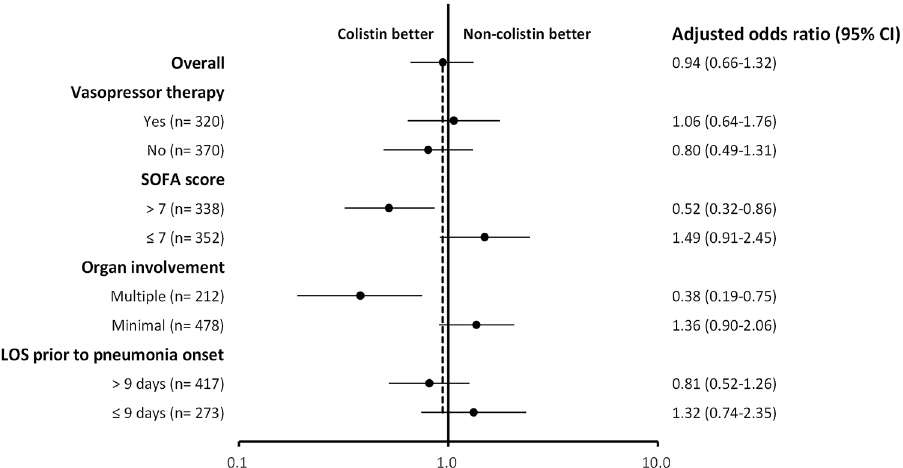
Figure 3. Forest plot of adjusted odds ratios for in-hospital mortality in the colistin-based group versus non-colistin-based group. Multivariate analysis adjusted for age, gender, smoking habit, comorbidities with liver disease, cerebral vascular disease, chronic kidney disease, LOS prior to pneumonia onset, SOFA score, supportive care with vasopressor therapy, and continuous renal replacement therapy. CI confidence interval, LOS length of stay, SOFA Sequential Organ Failure